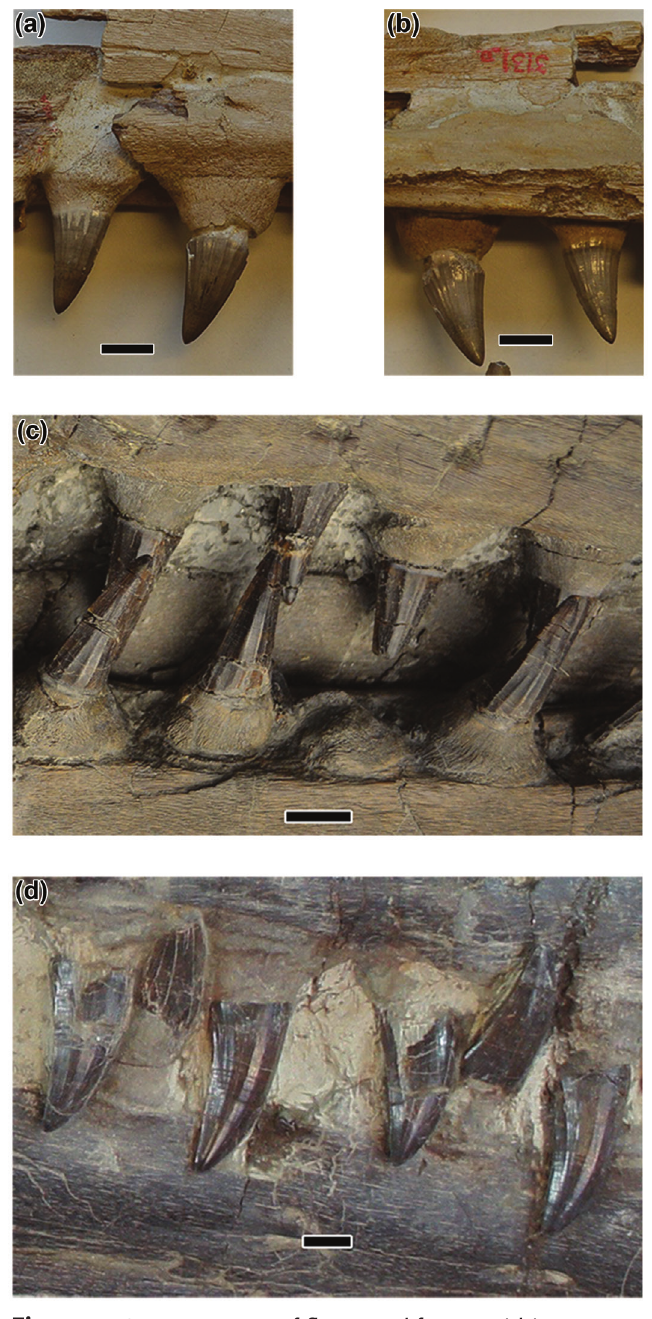
Figure 4. Co-occurrence of flutes and facets within a